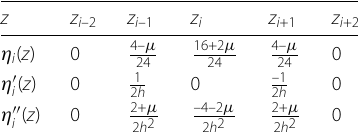
Table 1 The coefficients of ECBS η i ( z ) and their derivatives at node z i z z i